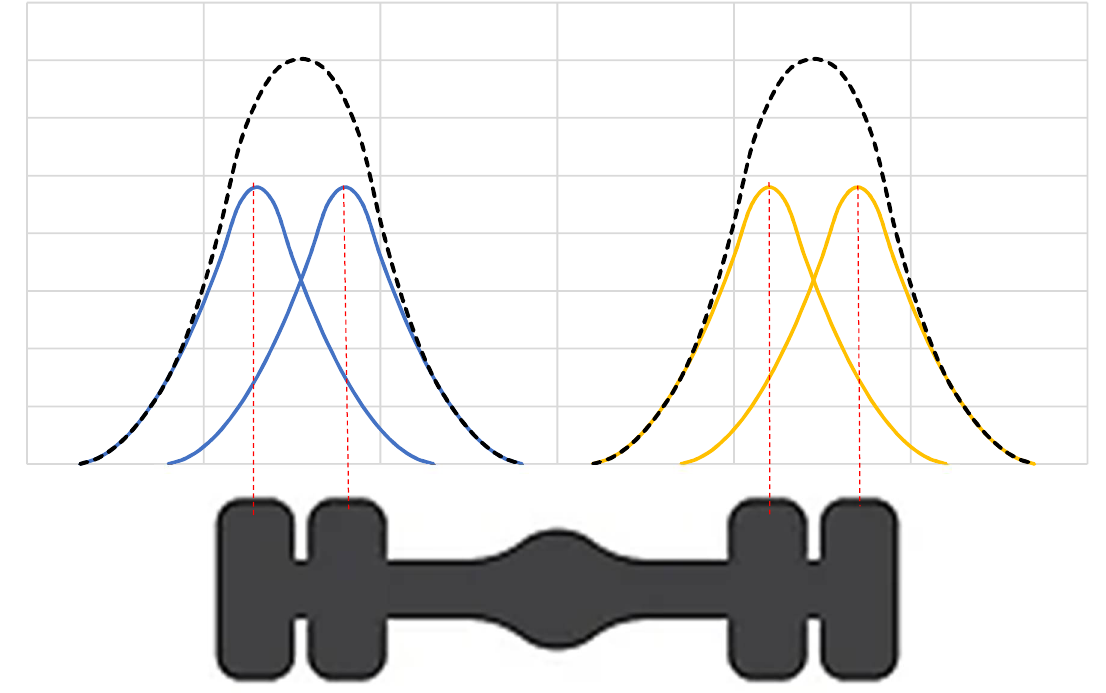
Figure 10. Superposition of the loading time distribution